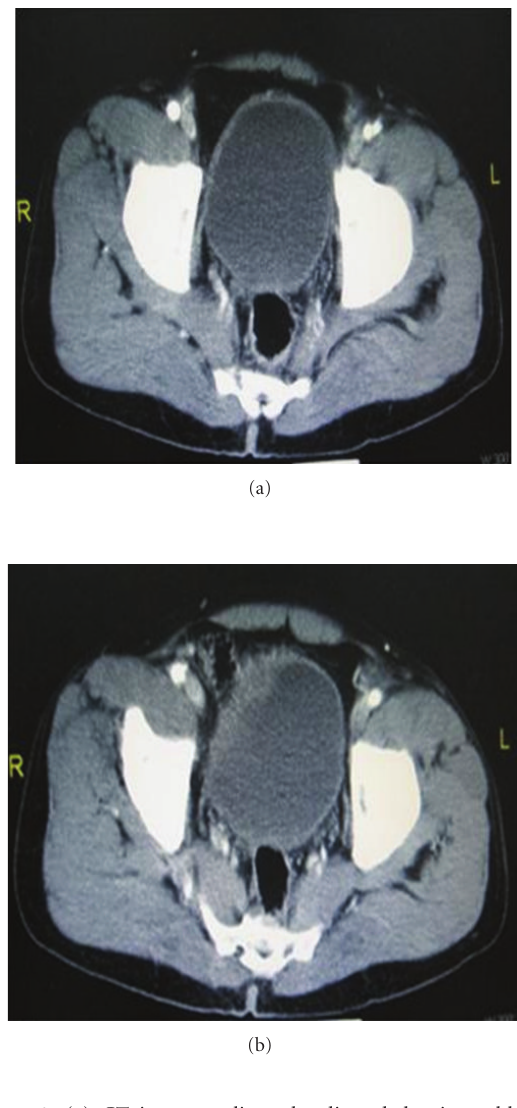
Figure 2: (a) CT image outlines the distended urinary bladder (UB). (b) CT image showing irregularity and thickening on the right side of UB wall.